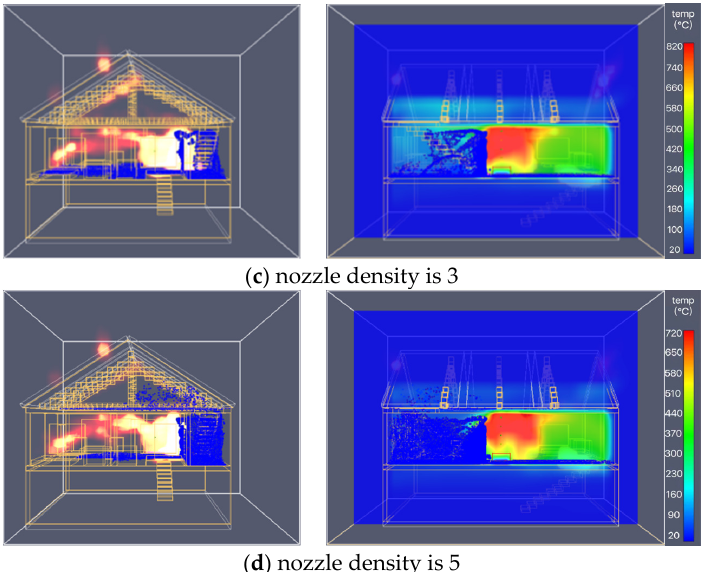
Figure 7. Temperature profiles of different nozzle densities at 480 s. Table 6. Temperatures of different nozzle densities at 200, 400, 600s, and 800.